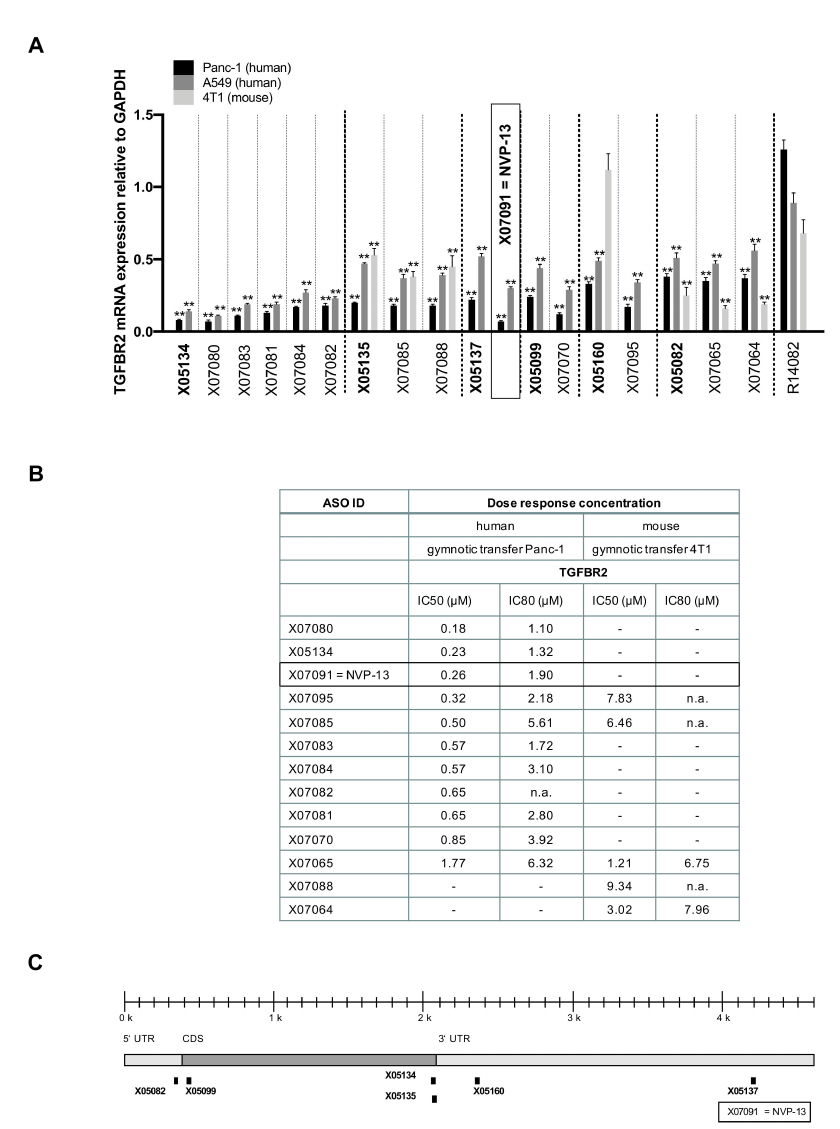
Figure 3. Activity, potency, and binding sites of parental sequences and their derivatives. ( A )